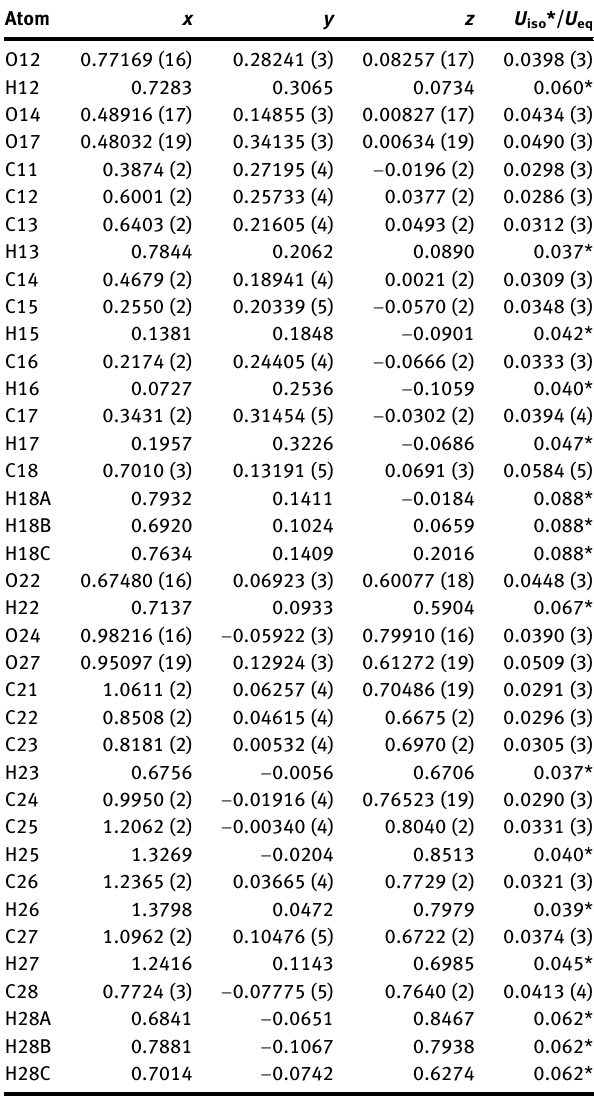
Table  : Fractional atomic coordinates and isotropic or equivalent isotropic displacement parameters (Å 